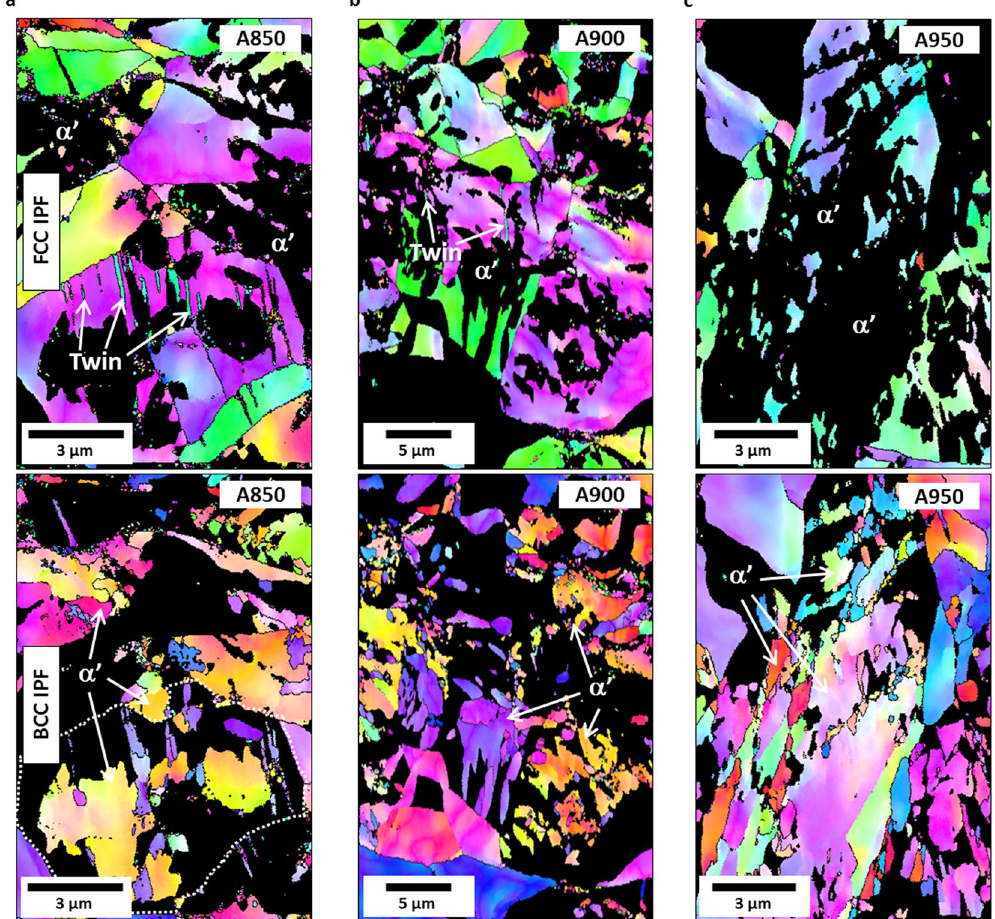
Figure 4. Deformation behavior with respect to TRIP and TWIP in Stage B of the annealed steels. ( a , b ) EBSD fcc and bcc IPF maps of the A850 and A900 steels at the true strain of 0.4. ( c ) EBSD fcc and bcc IPF maps of the A950 steel at the true strain of 0.2. In the A850 steel, a number of deformation twins and martensite are observed inside one austenite grain. In the A900 steel, only a few twins are found, while martensite is actively formed. Only martensite is formed without twins in the A950 steel.